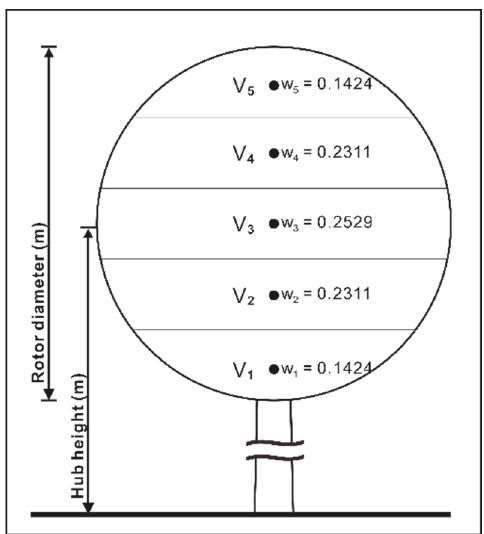
Figure 3. Rotor area fraction and corresponding weights for rotor equivalent wind speed (REWS) calculation.